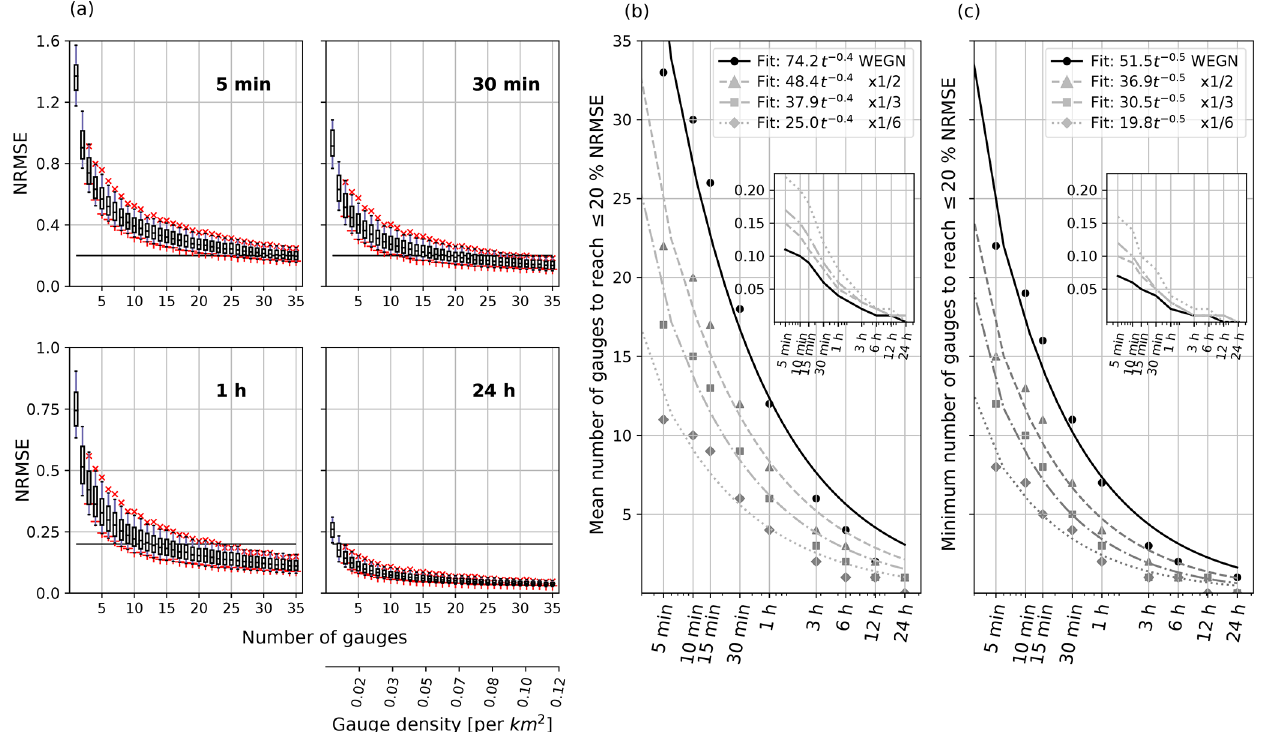
Figure 6. (a) Dependence of the accuracy of WEGN areal rainfall estimates on the number of gauges during heavy rainfall. Normalized RMSEs (NRMSEs) of 1000 random gauge combinations are used to assess the accuracy for each n -gauge network. Four selected time accumulations are shown. Black horizontal lines correspond to 20% NRMSE. Box plots display the median and 25th and 75th percentiles of NRMSE distribution, and whiskers extend to the 10th and 90th percentiles. Red crosses and x symbols show the median NRMSE for good and bad gauge configurations; 100 cases are selected, respectively, for each of the 1000 combinations. (b) The average number of gauges required to obtain areal rainfall estimates with the NRMSE < 20% within the whole WEGN area (black) and within the WEGN × 1 / 2, WEGN × 1 / 3, and WEGN × 1 / 6 areas (grey). Inset shows the results in terms of gauge density. (c) Same as (b) but for the minimum number of gauges required to obtain areal rainfall estimates with the NRMSE < 20%. Note that (a) shows the results with respect to the whole WEGN area.